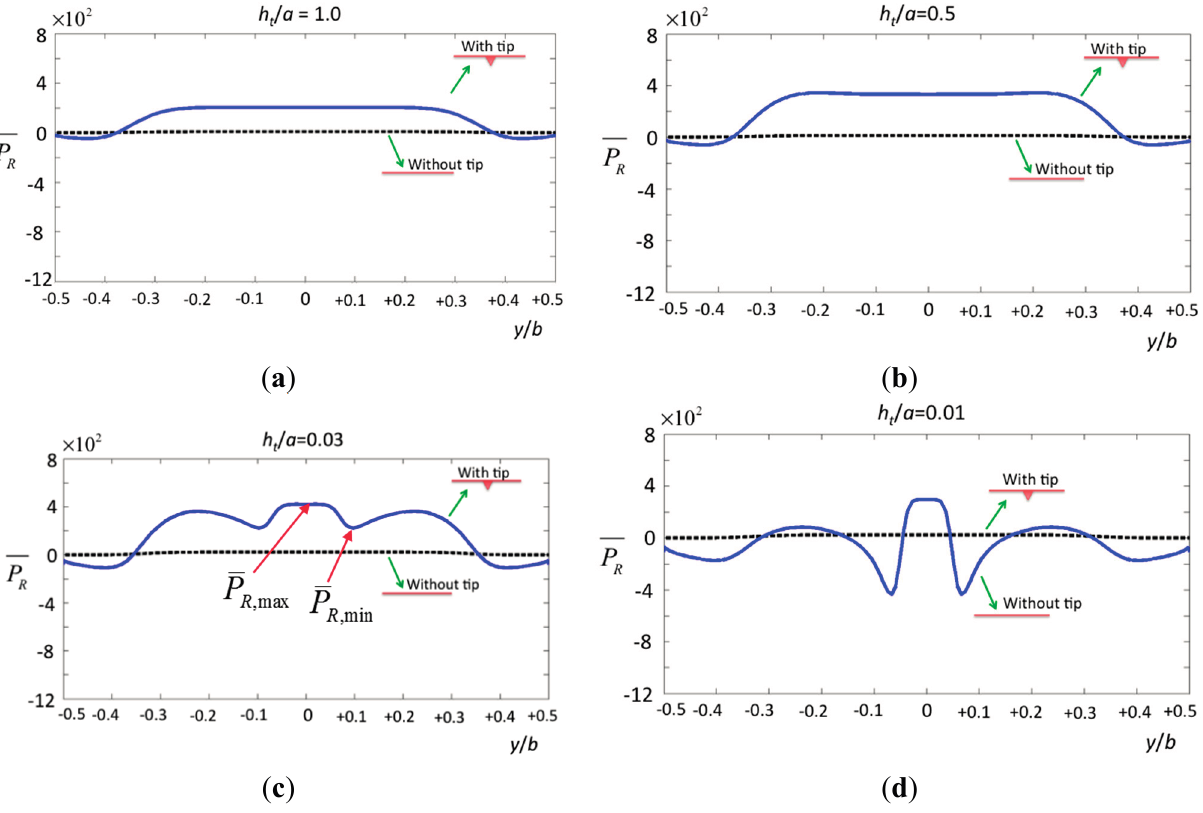
Figure 6. The normalized pressure in real part over the surface of the specimen by a cone tip with various tip–specimen distances ( a ) h t / a = 1.0; ( b ) h t / a = 0.5; ( c ) h t / a = 0.03; and ( d ) h t / a =